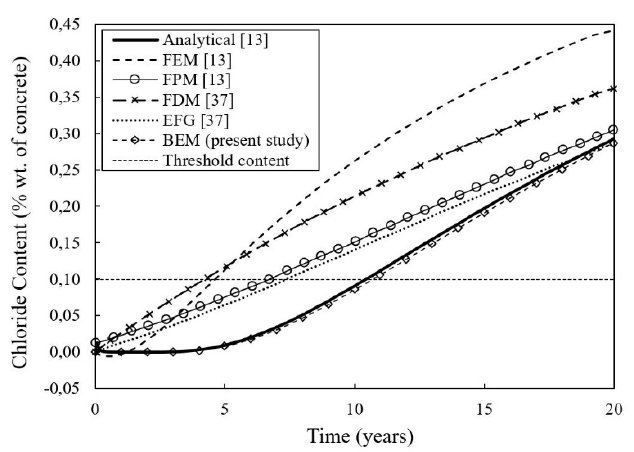
Figure 3. Chloride content evolution along time at 5 cm concrete